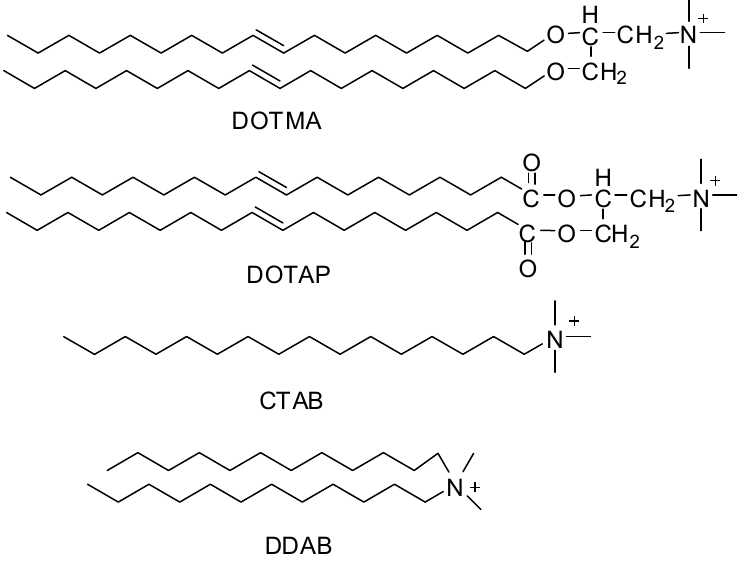
Figure 1. Chemical structures of cationic lipids.